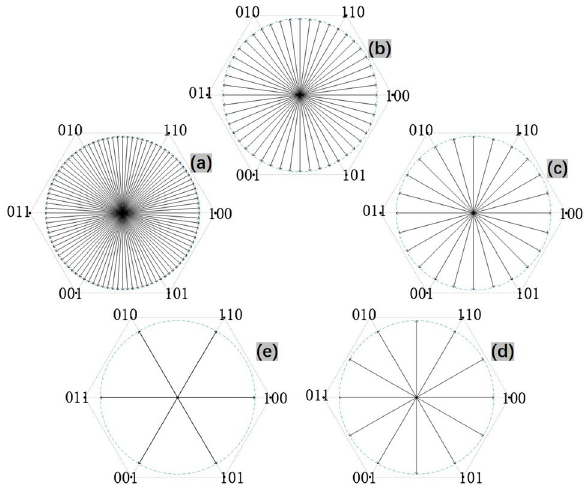
Figure 11. ( a ) ( e ) correspond subdivision from 96 to 6 separately. ∼